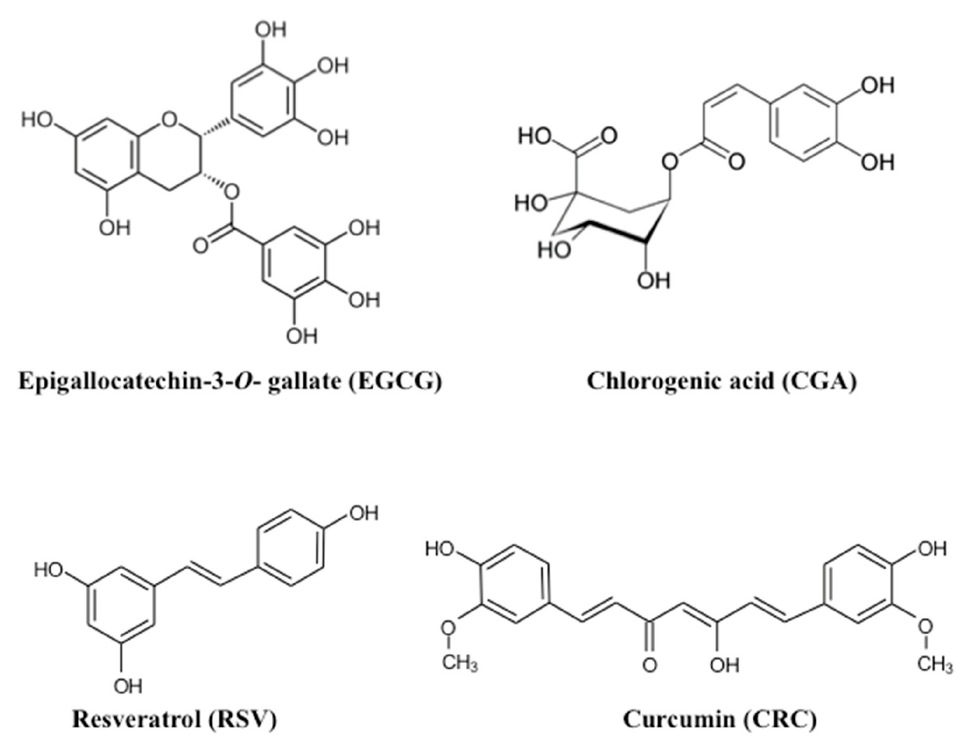
Figure 1. Chemical structures of epigallocatechin-3- O -gallate (EGCG), chlorogenic acid (CGA), resveratrol (RSV), and curcumin (CRC).